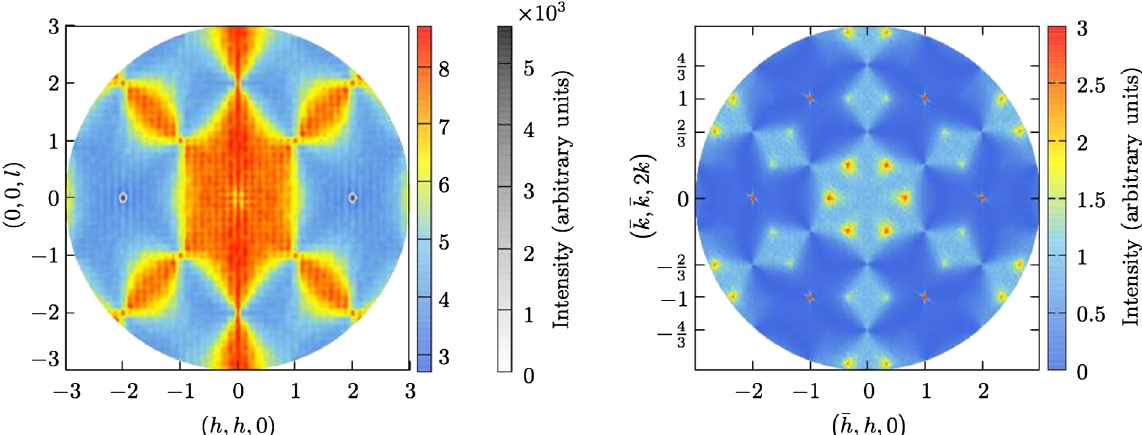
FIG. 4. Simulated unpolarized neutron-scattering structure factors S ð Q Þ for the pyrochlore monopole crystal (left) and for in-plane scattering from kagome ice (right). The pyrochlore S ð Q Þ has been calculated by averaging over 2000 distinct monopole-crystal ground states of a lattice with L ¼ 8 . In order to reveal the diffuse scattering, the Bragg peaks in the pyrochlore data are plotted as contours in gray scale superimposed on the contribution to S ð Q Þ from the dipolar field. The wave vector Q is in units of 2 (cid:4)=a 0 , where a 0 ¼ 4 a= is the lattice parameter of the cubic unit cell of the pyrochlore lattice. The kagome-ice data are taken from Ref.